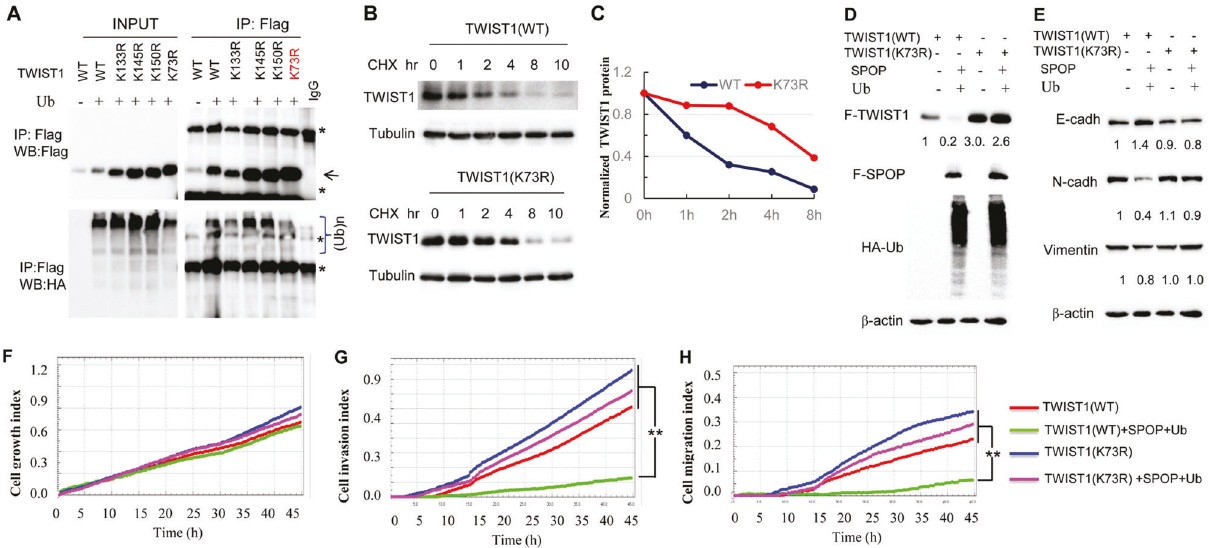
Fig. 7 K73 of TWIST1 is the major ubiquitinated site and K73R TWIST1 is resistant to SPOP degradation. A In vivo ubiquitination assays in HeLa cells transfected with Flag-tagged wild-typeTWIST1(WT), its mutant forms K133R, K145R, K150R, and K73R, respectively, along with HA- tagged ubiquitin (HA-Ub) constructs. This was followed by lysis of cells for IP with TWIST1 antibody, followed by IB analysis with indicated antibodies. B , C The protein half-life of K73R mutated TWIST1(K73R) was prolonged. Flag-tagged both wild-type and K73R mutated TWIST1 inducible overexpressed cells were treated with 20 µg/ml CHX after doxycycline (Dox) treatments for one day, and protein lysates were collected at the indicated times for western blotting. D K73R of TWIST1 is resistant to SPOP degradation. Flag-tagged wild-type or K73R mutated TWIST1 inducible overexpressed cells were transfected with or without Flag-tagged-SPOP along with HA-Ub, and protein lysates were collected for western blotting analysis. E K73R of TWIST1-attenuated SPOP promoted EMT marker regulation. The same protein lysates from Fig. D were used for western blotting analysis. K73R of TWIST1 attenuated SPOP promoted cell growth ( F ), invasion ( G ) and migration ( H ). Flag-tagged wild-type or K73R mutated TWIST1 inducible overexpressed cells were transfected with or without Flag-tagged-SPOP along with HA-Ub, and real-time cell growth index, migration and invasion assays were performed in a real time cell analyzer. All experiments were repeated at least three times. P -value ≤ 0.01 was considered as a signi fi cant difference (Fig. 7D, compare line 3 vs. lane 1; line 3 vs. lane 4). As expected, overexpression of TWIST1(K73R) overrode SPOP-mediated changes in EMT markers, including E-cadherin, N-cadherin, and Vimentin (Fig. 7E, lane 2 vs. lane 4; lane 3 vs. lane 4). Finally, we examined the impact of TWIST1(K73R) on invasion and migration of the cancer cells. Upon overexpression of TWIST1(K73R), together with SPOP, the cell growth index was barely affected (Fig. 7F). However, the capabilities of cell invasion and migration were signi fi cantly enhanced, compared with over- expression of TWIST1(WT) and SPOP (Fig. 7G, H, pink lines vs. green lines). Strikingly, the capabilities of cell invasion and migration were highest when cells were overexpressing TWIST1(K73R) alone (Fig. 7G, H, blue lines vs. pink lines, red or green lines). We conclude that K73 of TWIST1 is critical for TWIST1 stabilization, thus promoting cancer cell migration and invasion. DISCUSSION SPOP has been demonstrated a tumor suppresser. Cancer genome analysis has identi fi ed recurrent missense mutations in the SPOP gene in 11~13% of primary prostate cancer (PC) [20 – 22] and in 6~8% of metastatic and castration-resistant PC [23]. As an important member of the E3 ubiquitin- ligase complex [17, 18], most studies on SPOP mainly focused on PC but not on breast cancer [18, 20, 22, 23, 25]. While SPOP functions in breast cancer tumorigenesis and progression are not fully determined [31], Li et al fi rst demonstrate that SPOP interacts directly with SRC-3 in a phosphorylation-dependent manner, thus targeting SRC-3 in breast cancers. Breast cancer metastasis suppressor 1 (BRMS1) [44], progesterone receptor (PR) [45] and c-Myc [46] have been indicated as direct targets of SPOP in breast cancer for ubiquitin- dependent proteasomal degradation. Little is known regarding the SPOP gene mutations in Chinese breast cancer patients so far